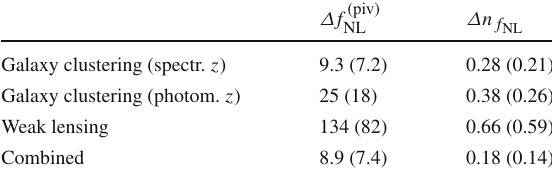
Table 24 Forecast 1 σ errors for a scale-dependent local model of primordial non-Gaussianity (Giannantonio et al. 2012b). Details of the forecasts are as in the previous Table